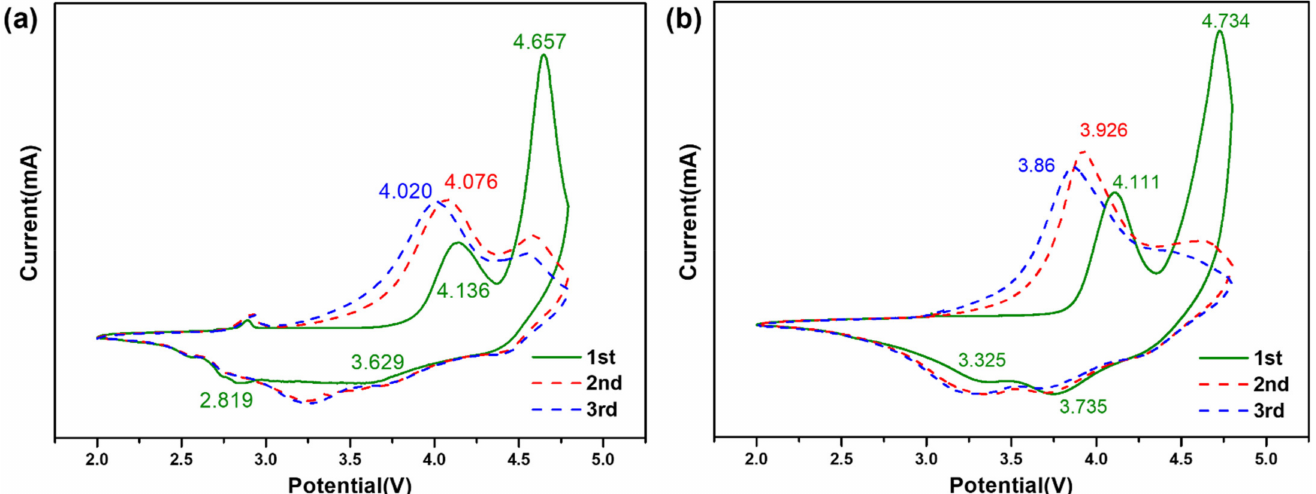
Figure 5. CV curves of initial three cycles in the potential range of 2.8–4.8 V for ( a ) LMR and ( b )